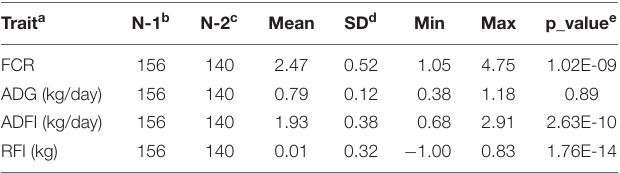
a FCR, feed conversion ratio; ADG, average daily gain; ADFI, average daily feed intake; RFI, residual feed intake. b N-1 = number of individuals for each trait in the first batch. c N-2 = number of individuals for each trait in the second batch. d SD = standard deviation. e p_value = p-value of Student’s test for two batches data at significance level